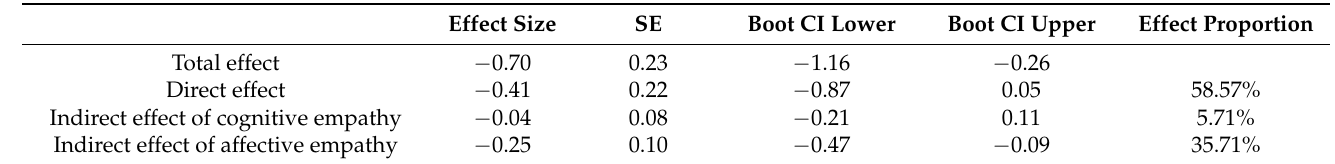
Table 4. Regression coefficients, standard errors, and effects for the hypothetical mediation model (perspective taking and empathic concern as